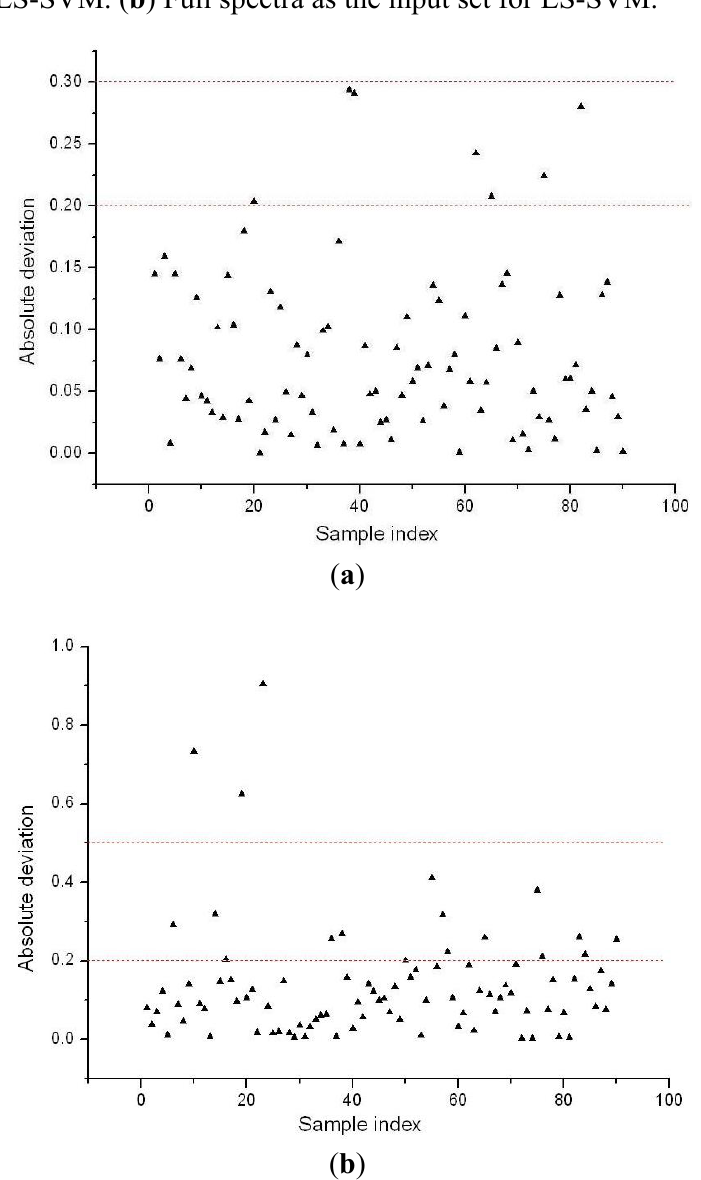
Figure 5. The absolute deviation value of prediction results of validation set (sample index 1–30 for Cc lubricant, 31–60 for Hxyg lubricant, and 61–90 for Ca lubricant). ( a ) BVB